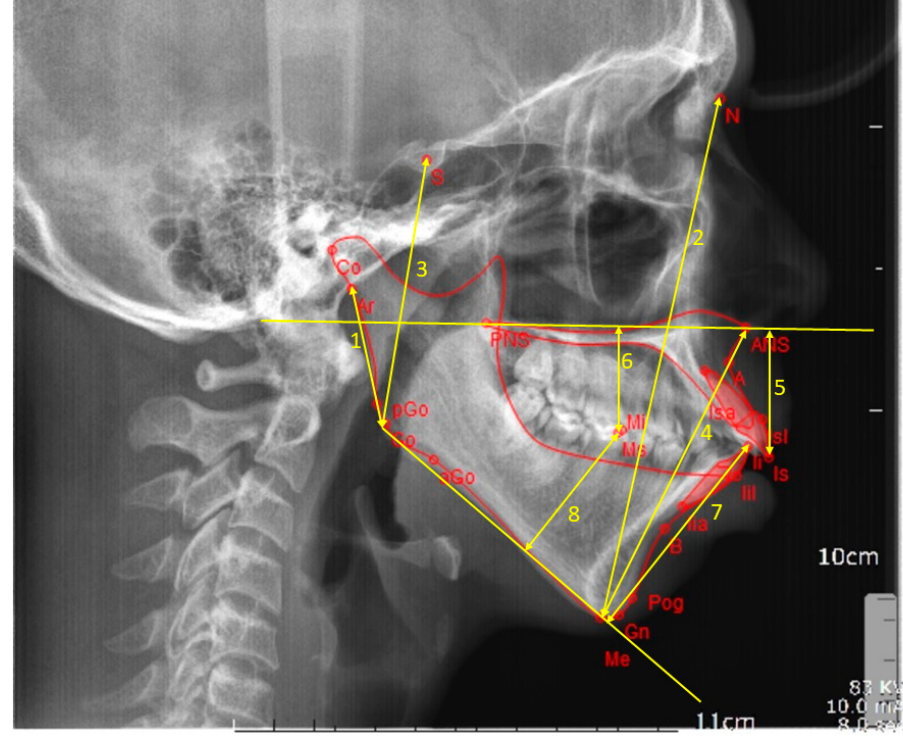
Figure 2. Linear cephalometric measurements. 1 = ramus height, 2 = anterior facial height, 3 = posterior facial height, 4 = lower anterior facial height, 5 = upper incisor to maxillary plane, 6 = upper molar to maxillary plane, 7 = lower incisor to mandibular plane, and 8 = lower molar to mandibular plane. Table 1. Cephalometric parameters used for measurement.